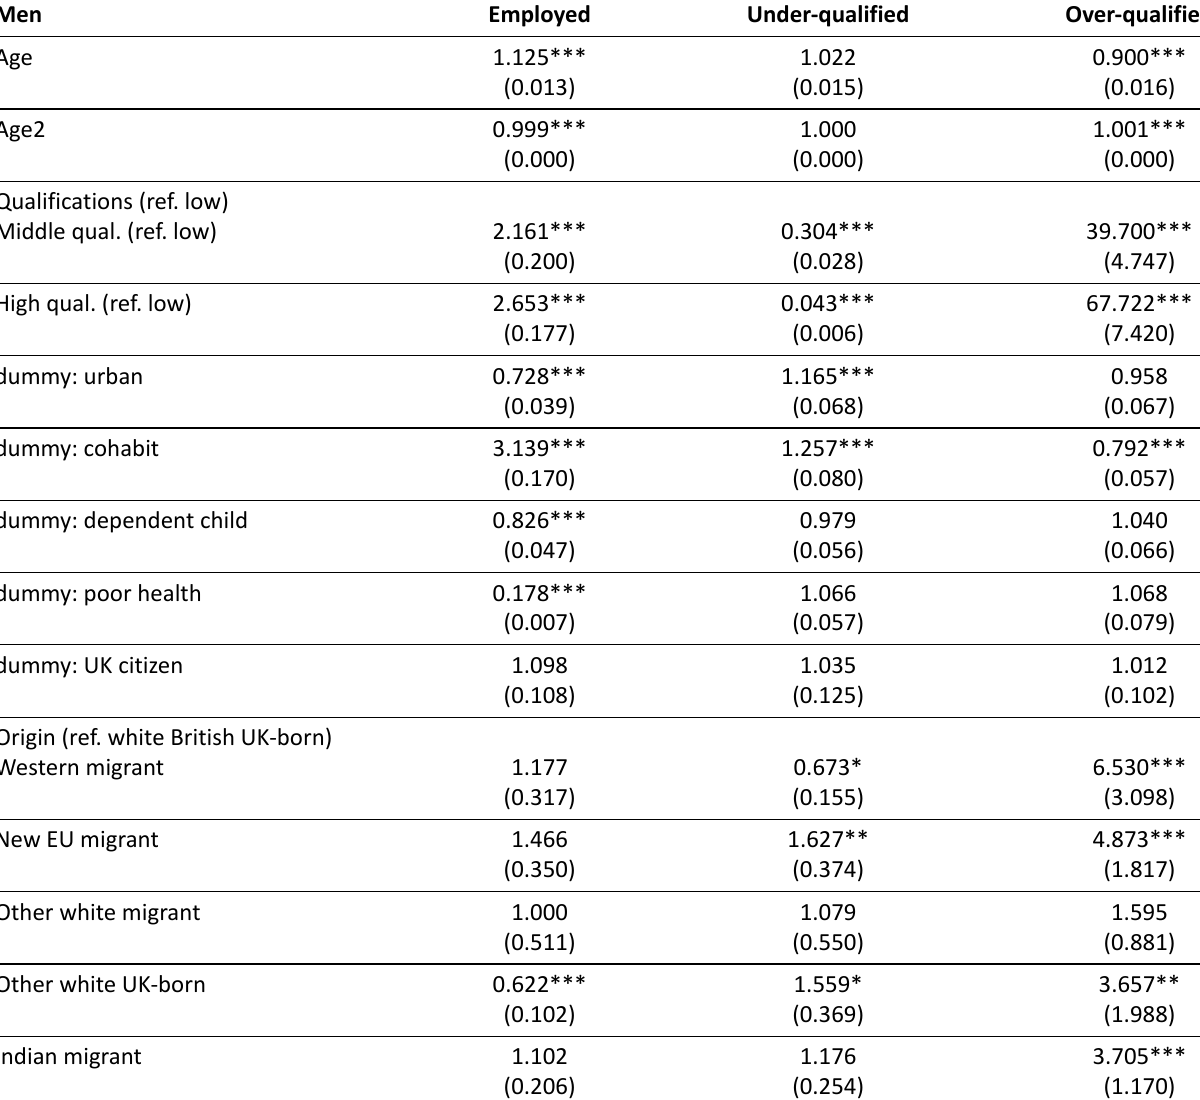
Table A3. Binary logistic regression model (odds ratio) of employment, under- and over-qualification for men. Men